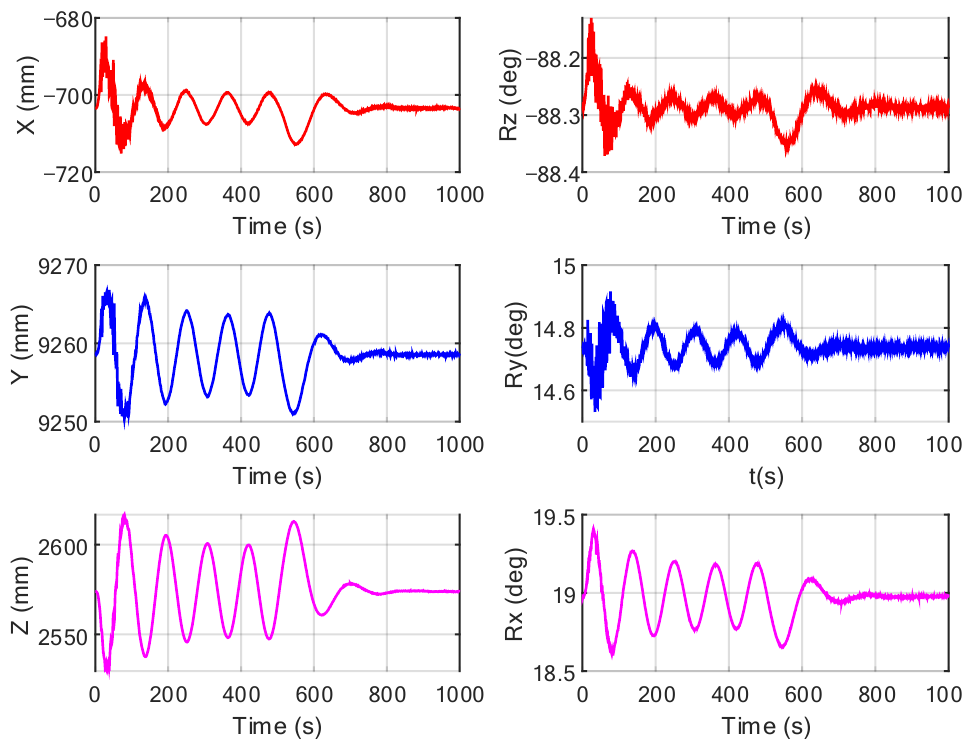
Figure 10. The end position and orientation of